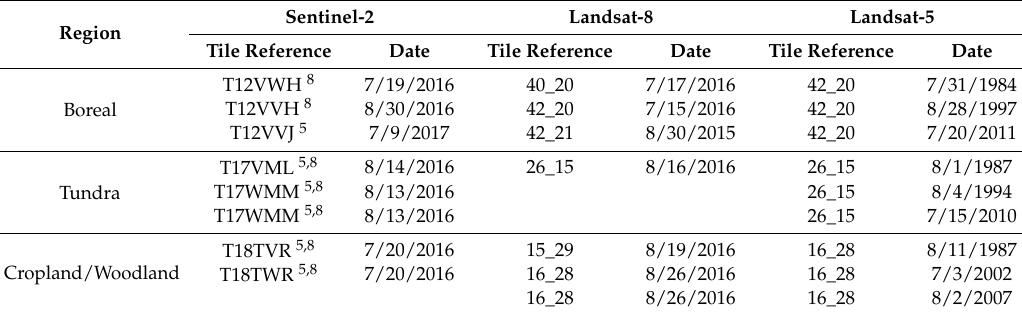
Table 1. Landsat and Sentinel-2 images used for training and